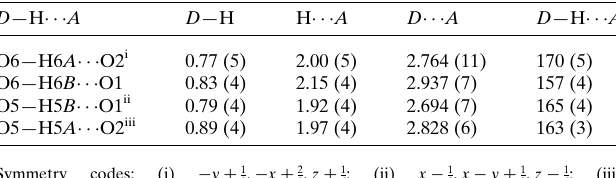
Table 1 Hydrogen-bond geometry (A˚ , (cid:3) ) at 273